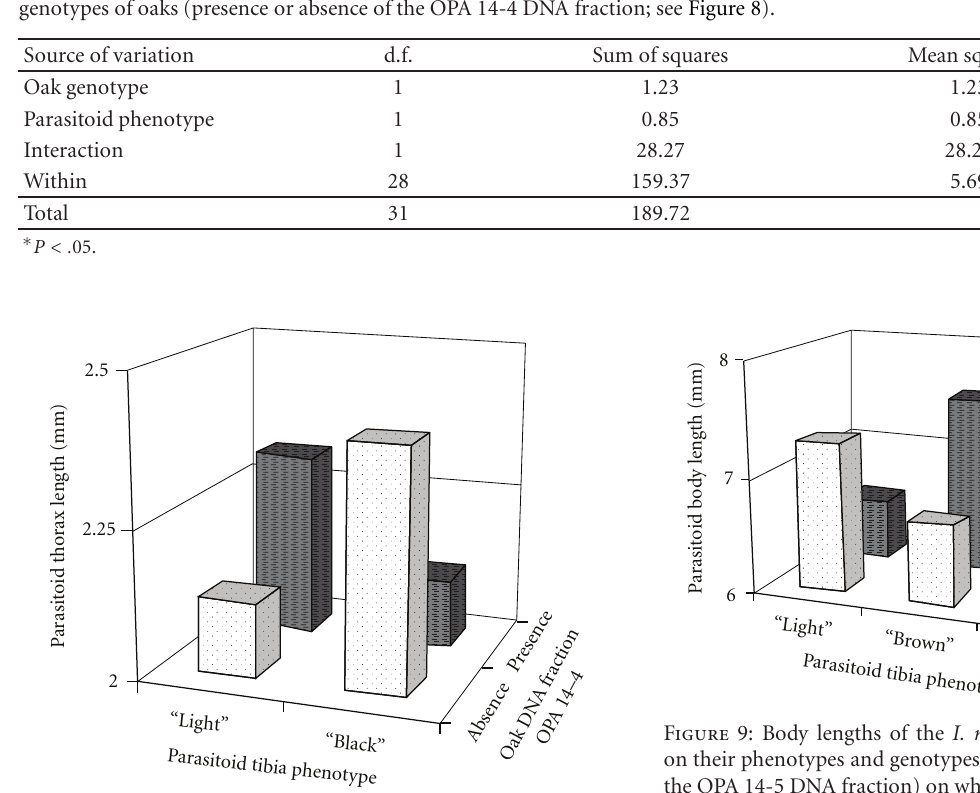
Figure 8: Thorax lengths in the I. maculator males in dependence on their phenotypes and genotypes of oaks (presence or absence of the OPA 14–4 DNA fraction) on which their host insect pupae were developed (results of two-way ANOVA in Table 4).